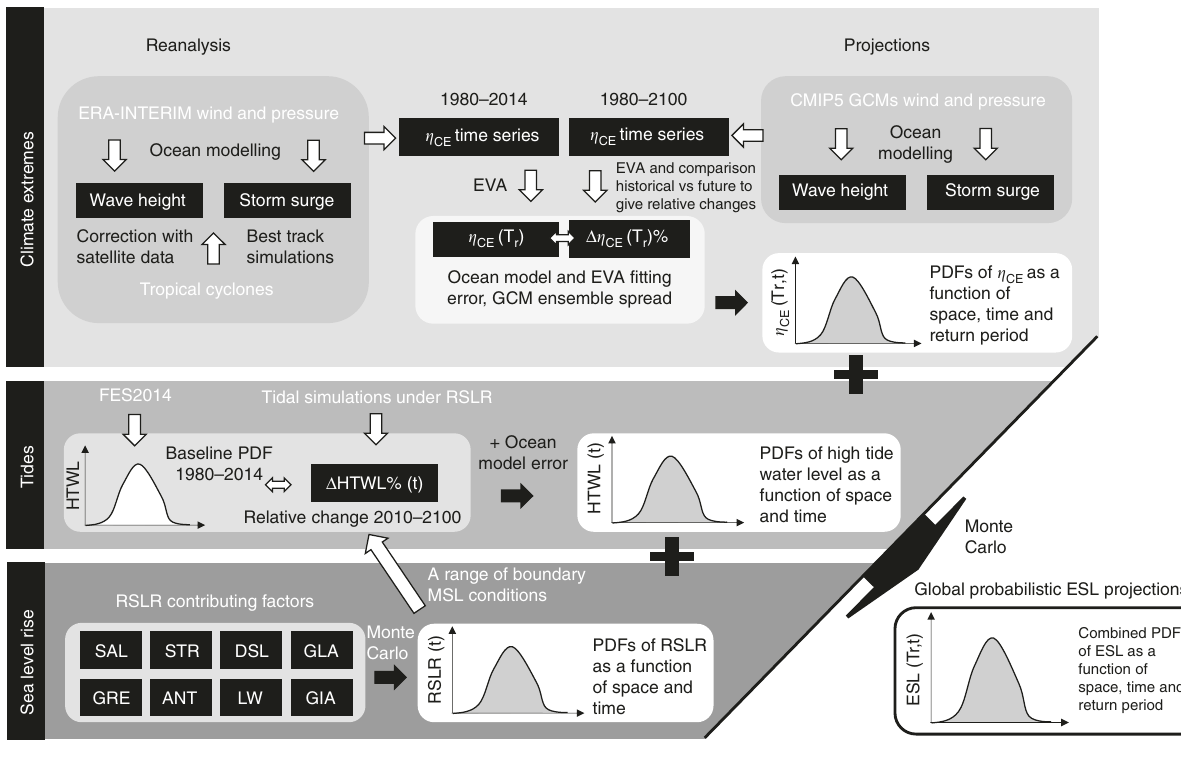
Fig. 1 Flow diagram showing the procedure to generate the ESL projections. Key: HTWL; high tide water level; η CE , water level due to climate extremes; PDF, probability density function; EVA, extreme value analysis; RSLR, relative sea-level rise; SAL, self-attraction and loading of the ocean upon itself due to the long term alteration of ocean density changes; STR, steric sea-level change; DSL, dynamic sea-level change; GLA, surface mass balance of ice from glaciers and ice-caps; GRE/ANT, surface mass balance and ice dynamics of Greenland/Antarctic ice sheets; LW, land-water storage and; GIA, Glacial Isostatic